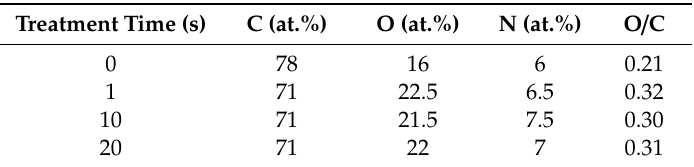
Table 1. The elemental composition of untreated and DBD-treated Kapton as measured by X-ray photoelectron spectroscopy